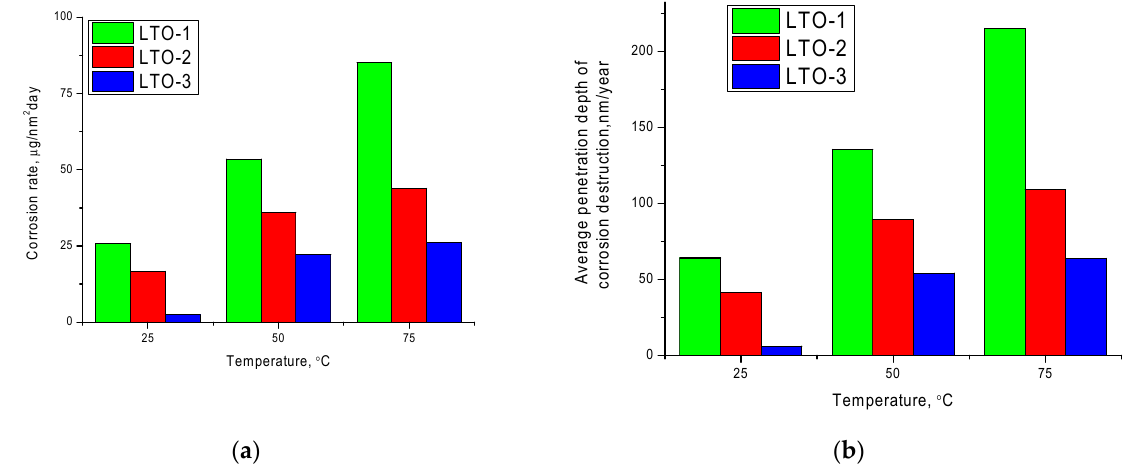
Figure 4. ( a ) Graph of changes in the specific corrosion rate; ( b ) Graph of changes in average depth of corrosion penetra- tion.